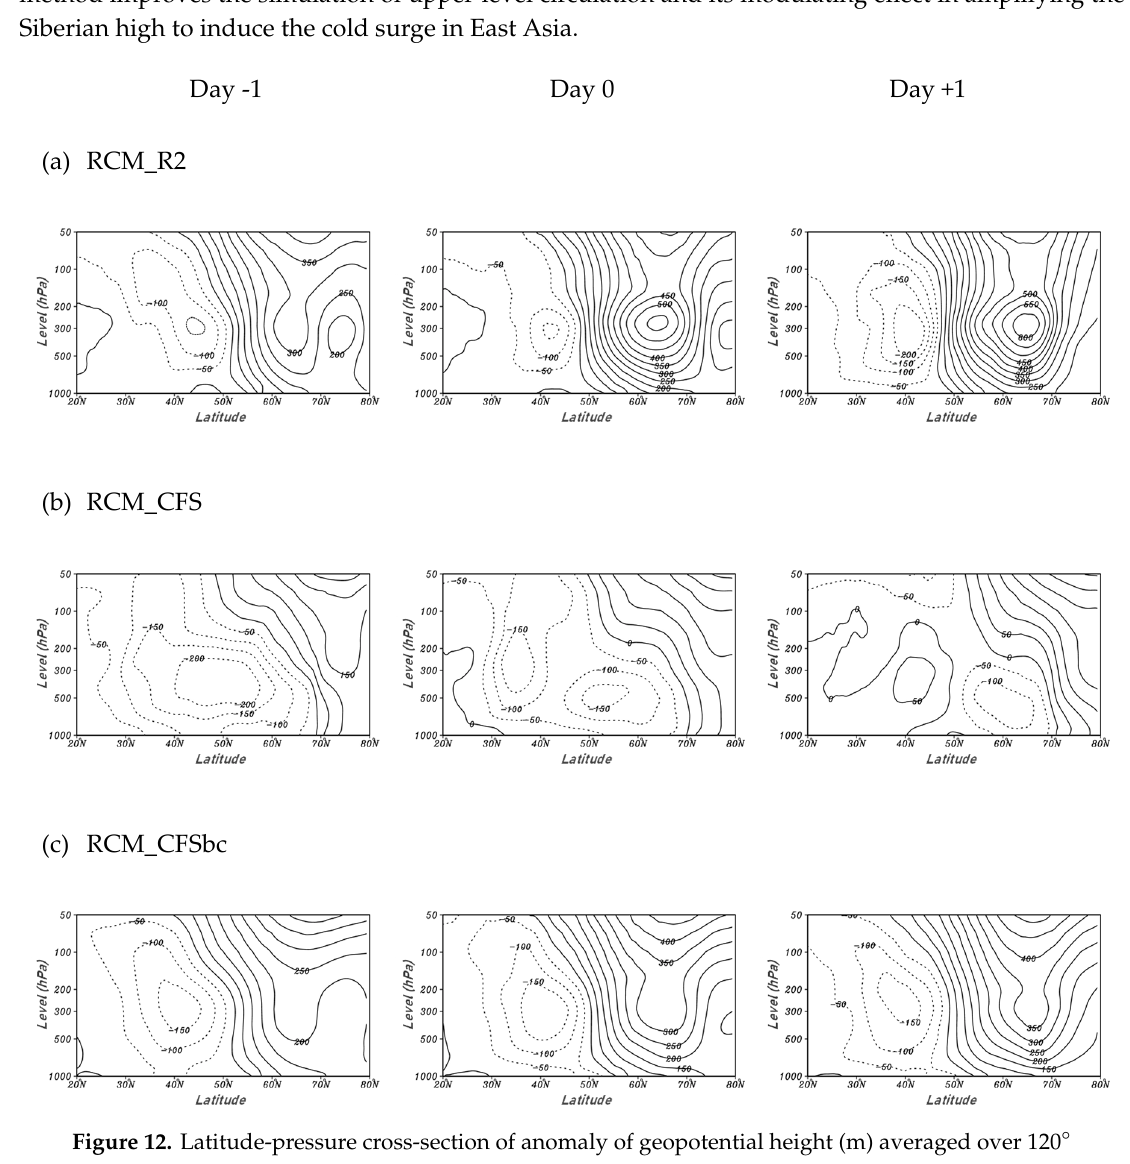
Figure 12. Latitude-pressure cross-section of anomaly of geopotential height (m) averaged over 120° E–140° E for ( a ) RCM_R2, ( b ) RCM_CFS, and ( c ) RCM_CFSbc experiment during − 1 day to +1 day relative to the cold surge occurrence on 2 December 2005. Contour intervals are 50 m (solid and dashed lines indicate positive and negative values, respectively).